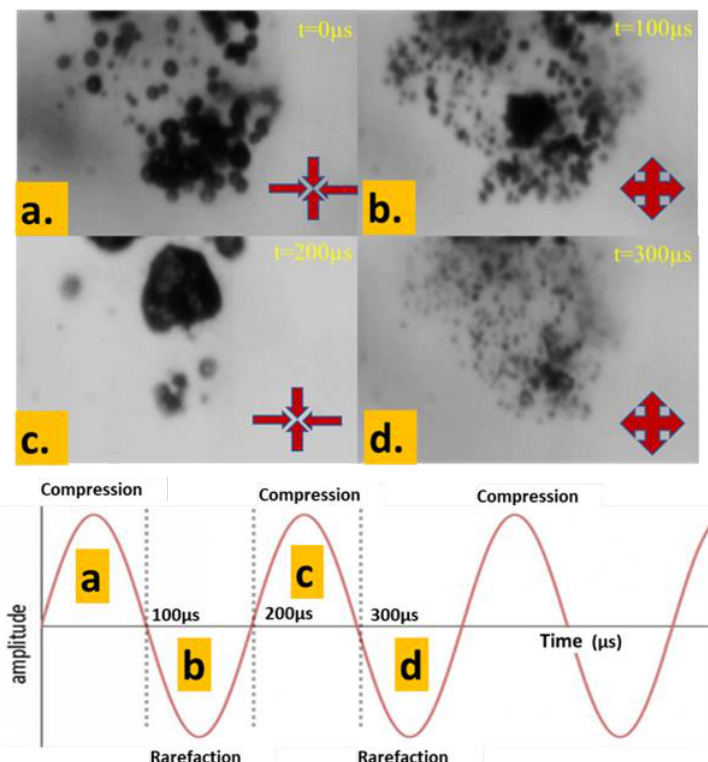
Figure 6. The multi-bubble cloud’s behavior during 300 µs at the applied acoustic field of 40 kHz: ( a ) and ( c ) compression cycle, ( b ) and ( d ) rarefaction cycle.